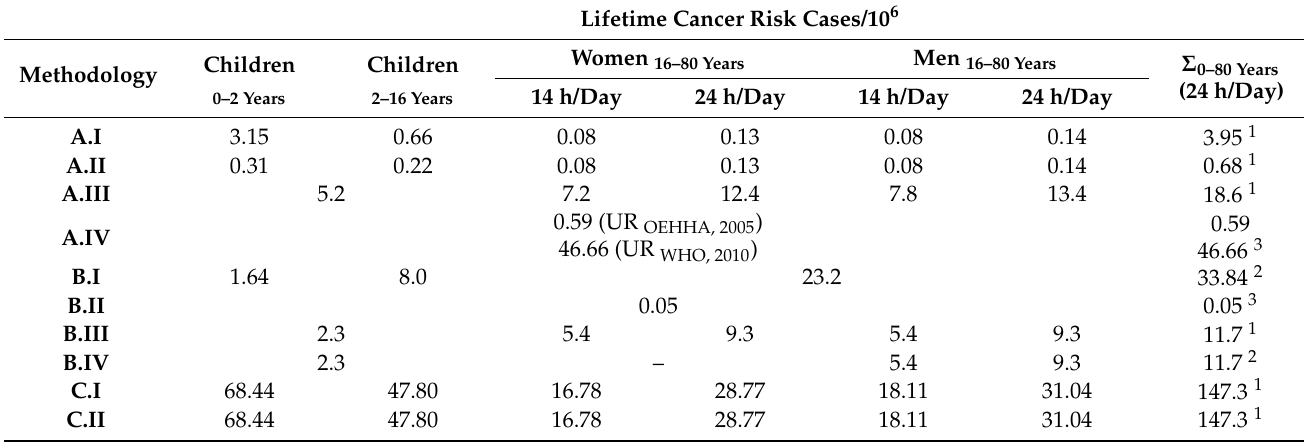
Table 5. Potential cancer risk assessment for Elefsina area.